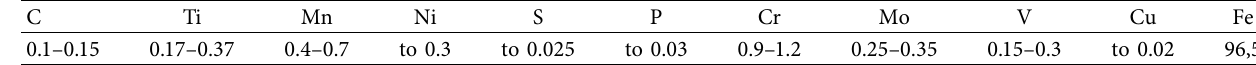
Table 1: Chemical composition (%) of 12Kh1MF